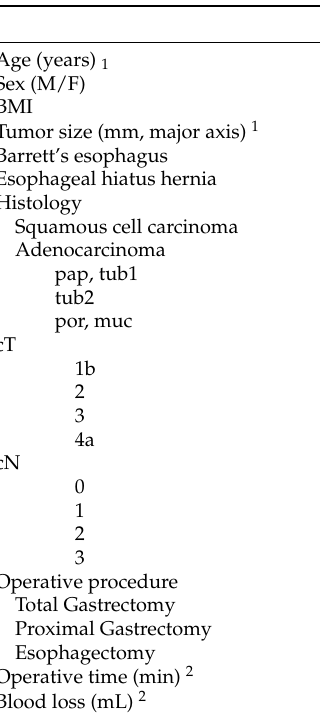
Table 2. Characteristics of patients with pathologically diagnosed EGJ cancer ( n =